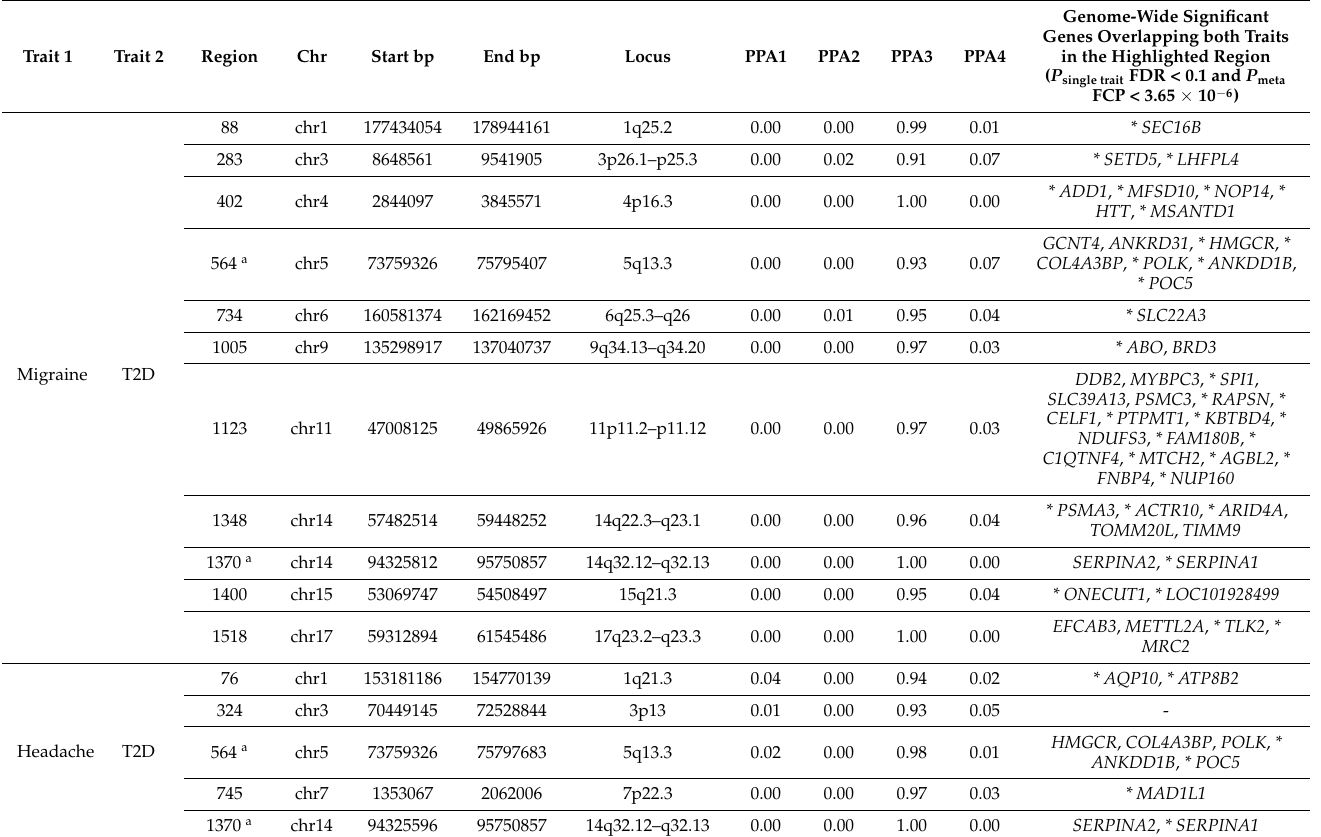
Table 2. Pleiotropic genomic regions (posterior probability of association [PPA3] > 0.9) of migraine and headache with T2D using GWAS pairwise